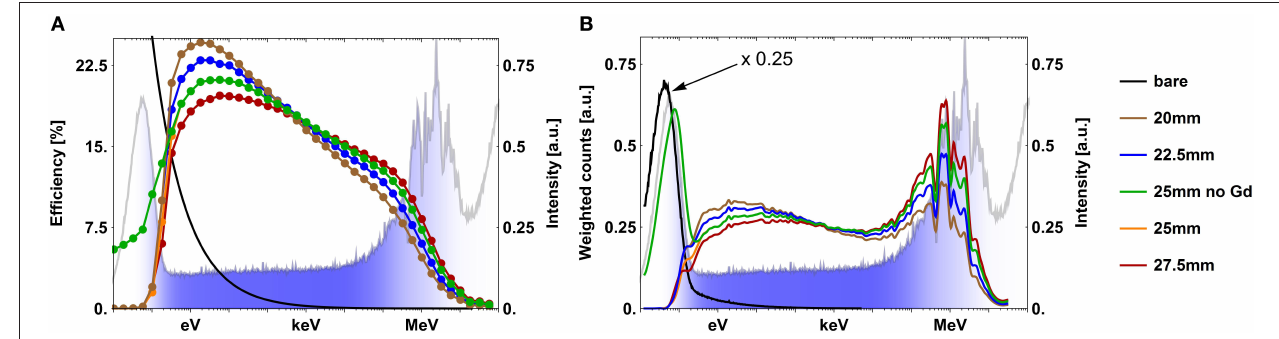
FIGURE 3 | (A) Response functions of a bare neutron counter and detectors with moderator thicknesses of 20–27.5mm in steps of 2.5mm. All models except for one of the 25mm versions are equipped with a thermal shield. The thermal shield consists of a Gd 2 O 3 layer with a thickness of 90 µ m in order to provide a sufficiently high absorption cross section for the thermal peak. The chosen thickness reduces the spectral count rate for energies below 100meV to approximately 1%. For this study the reference density for the high density polyethylene moderator was chosen to be 0.95g/cm 3 . The detector model is based on the 3 He Rover, introduced in Desilets et al. (2010) and analyzed by Köhli et al. (2018). In order to compare energy ranges a cosmic-ray neutron spectrum above the soil at 20% soil moisture and 15g/m 3 air humidity simulated by MCNP (Goorley et al., 2012) is drawn. The dry soil consists to 75% of SiO 2 and to 25% of Al 2 O 3 with a porosity of 50%. The sensitivity to hydrogen according to Figure 1 is shown by the shaded blue filling. (B) Weighting of this neutron spectrum with the response functions reveals the total count rate contribution of the different energy domains. The weighted count rate of the bare counter are decreased by a factor of